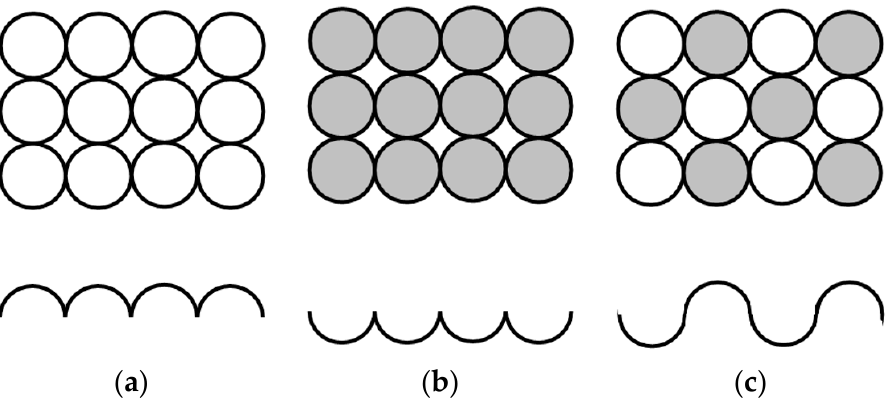
Figure 16. Road unevenness schemes: ( a )—convexities; ( b )—concavities; ( c )—combination of con- vexities and concavities.